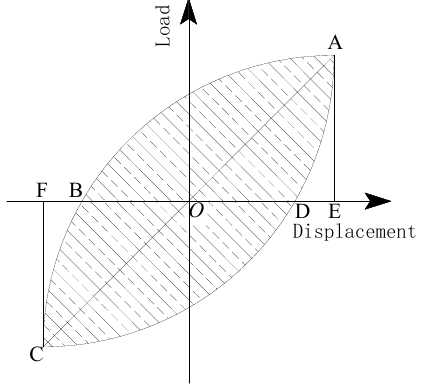
Figure 8. Calculation of schematic diagram of equivalent viscous damping ratio . Table 2. Load and displacement at characteristic points, and displacement ductility factor .